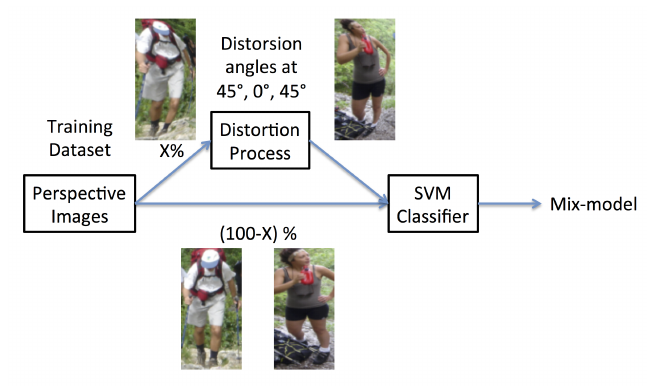
Figure 9. Flowchart of the proposed mix training detection